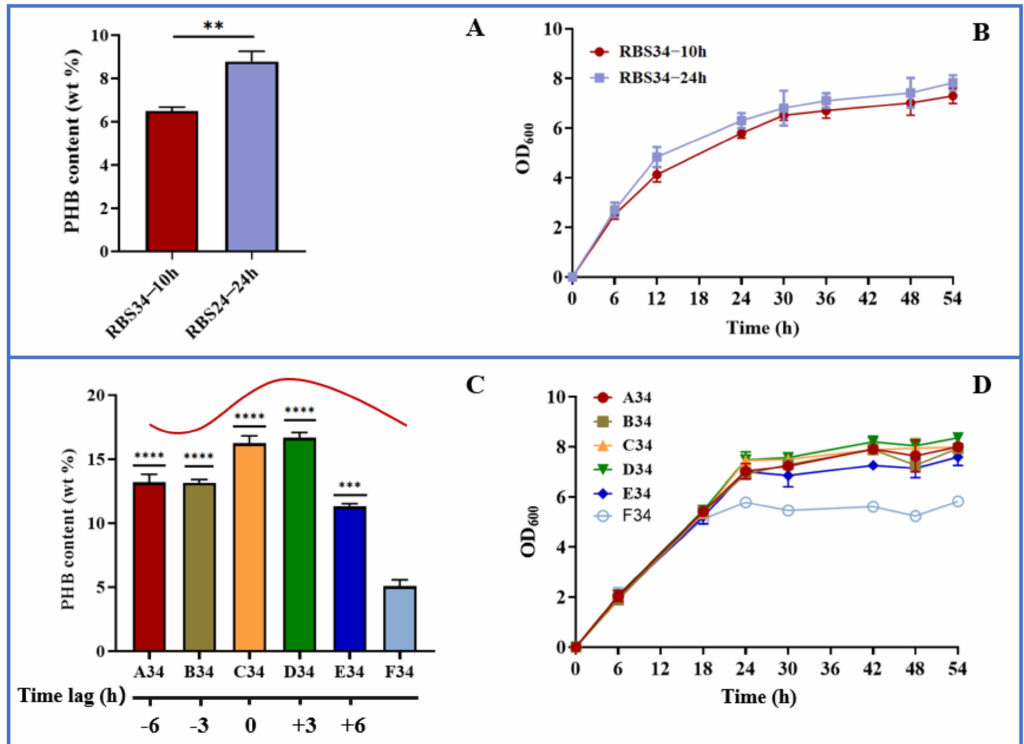
Figure 6. Dynamic regulation of cell growth and PHB production using optogenetic dual-switch system. ( A , B ) gltA repression and phbCAB activation were simultaneously regulated in strain RBS34 during two growth phases (at 10 and 24 h) by using red and blue light. ( C , D ) In strain RBS34, phbCAB was activated at 24 h, and gltA was repressed at 18 (A34, time lag of − 6 h), 21 (B34, time lag of − 3 h), 24 (C34, time lag of 0 h), 27 (D34, time lag of +3 h), or 30 h (E34, time lag of +6 h). All results were calculated with three ( n = 3) independent replications. Error bars represent means ± standard errors of the mean (SEMs). ** p < 0.01, *** p < 0.001, **** p <